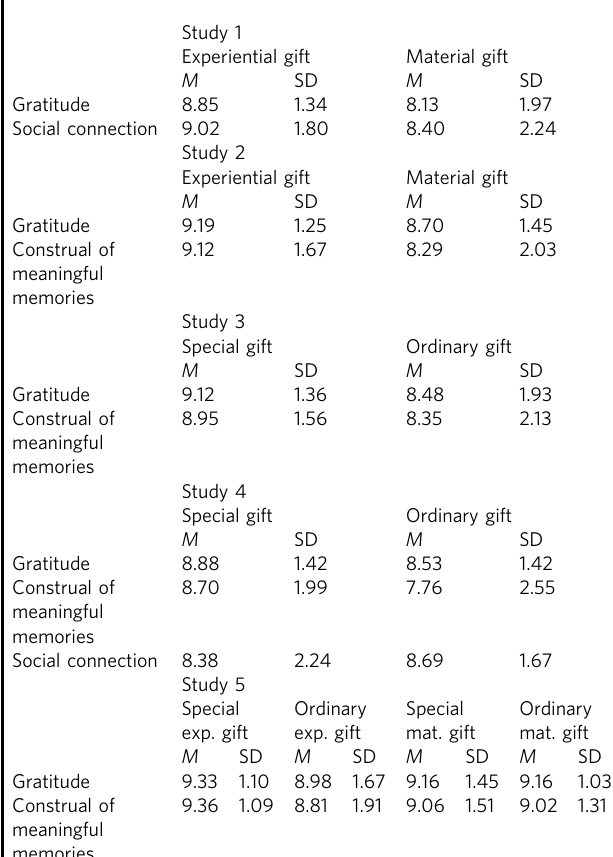
Table 1 Descriptive statistics of studies 1, 2, 3, 4, and